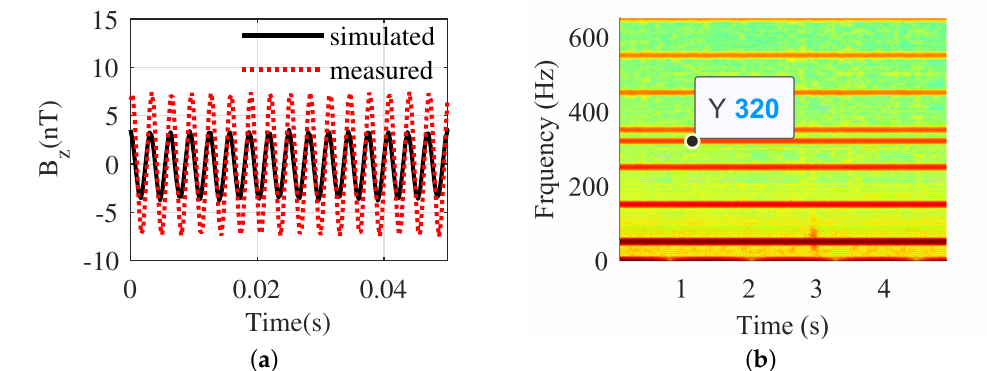
Figure 9. ( a ) Field at the point 3 m away from the shutter antenna. ( b ) Spectrogram of